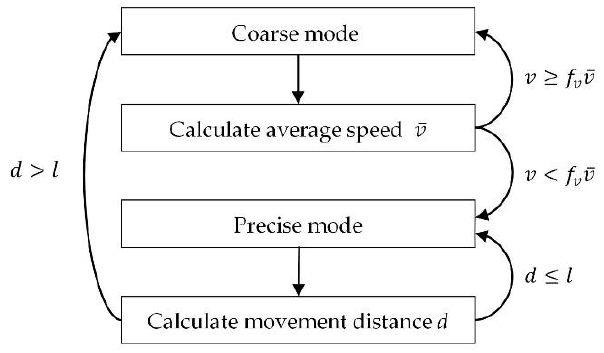
Figure 7. Mode switch state machine.